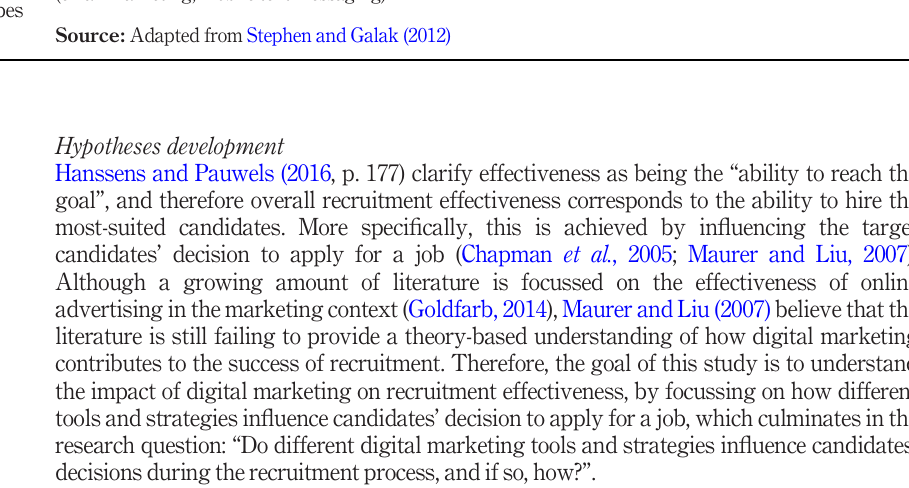
Table 2. Distribution of digital